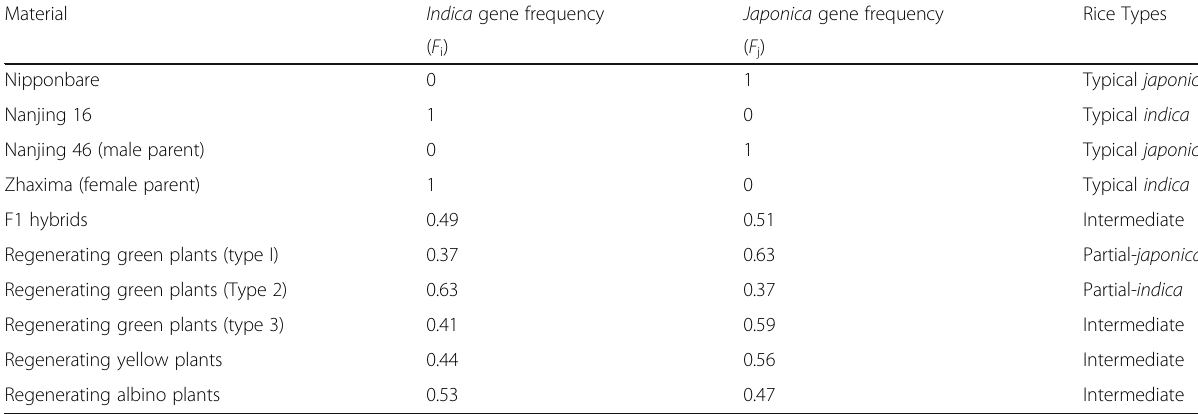
Table 3 Indica ( F i ) and japonica ( F j ) gene frequencies in rice samples a